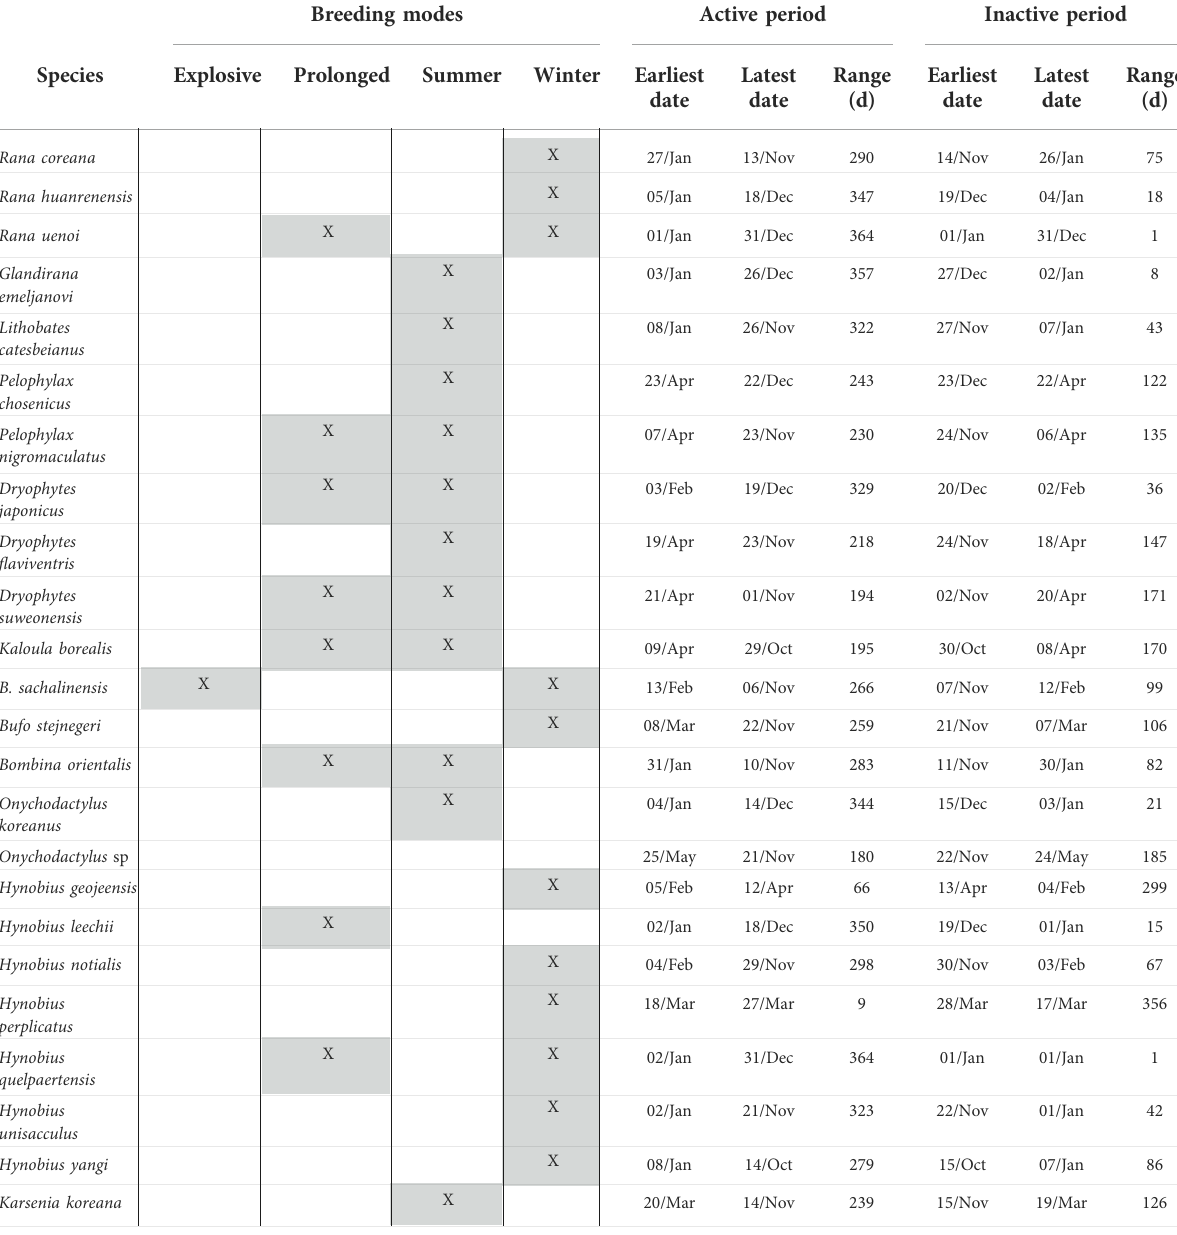
TABLE 4 Details on inactive period and breeding modes for all amphibian species of the Republic of Korea, based on 8,763 citizen science observationscollectedbetween02March1997and01December2020downloadedfromtheplatformiNaturalist.Duetothelackofdata( n =12) Onychodactylus sp. was taken out of the